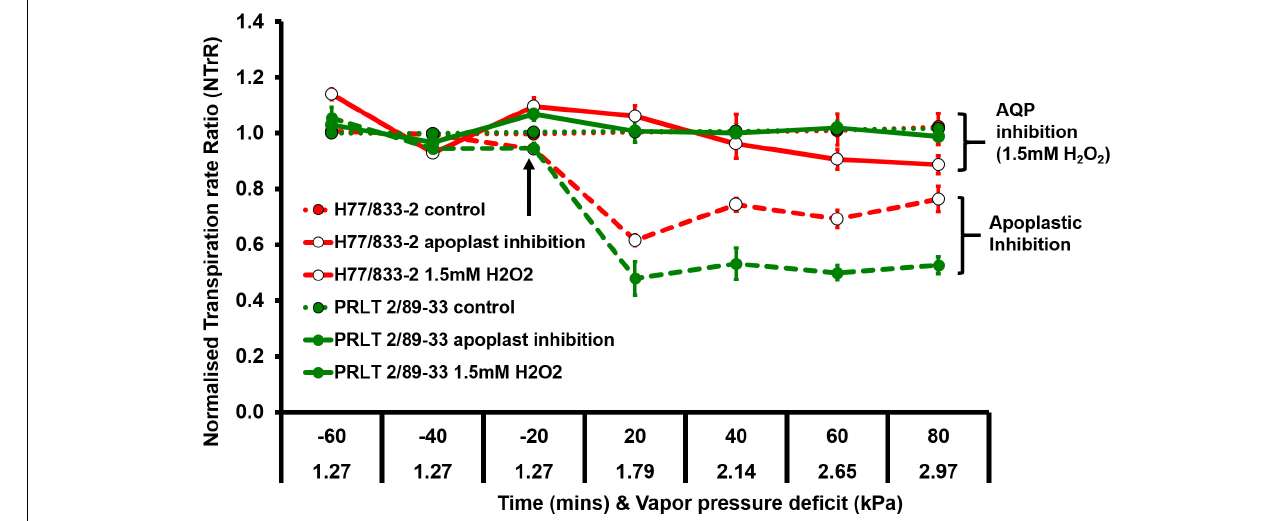
FIGURE 3 | Genotypic difference in transpiration response of H77/833-2 (high Tr, open circle) and PRLT-2/89-33 (low Tr, closed circle) to AQP and apoplastic inhibition (adopted from Tharanya et al., 2018).